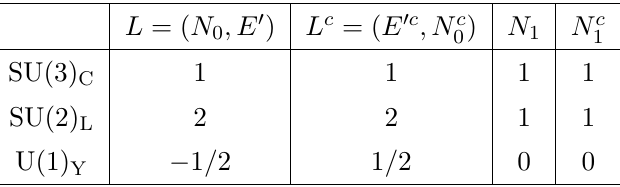
) under the Standard Model SU(3) C 1